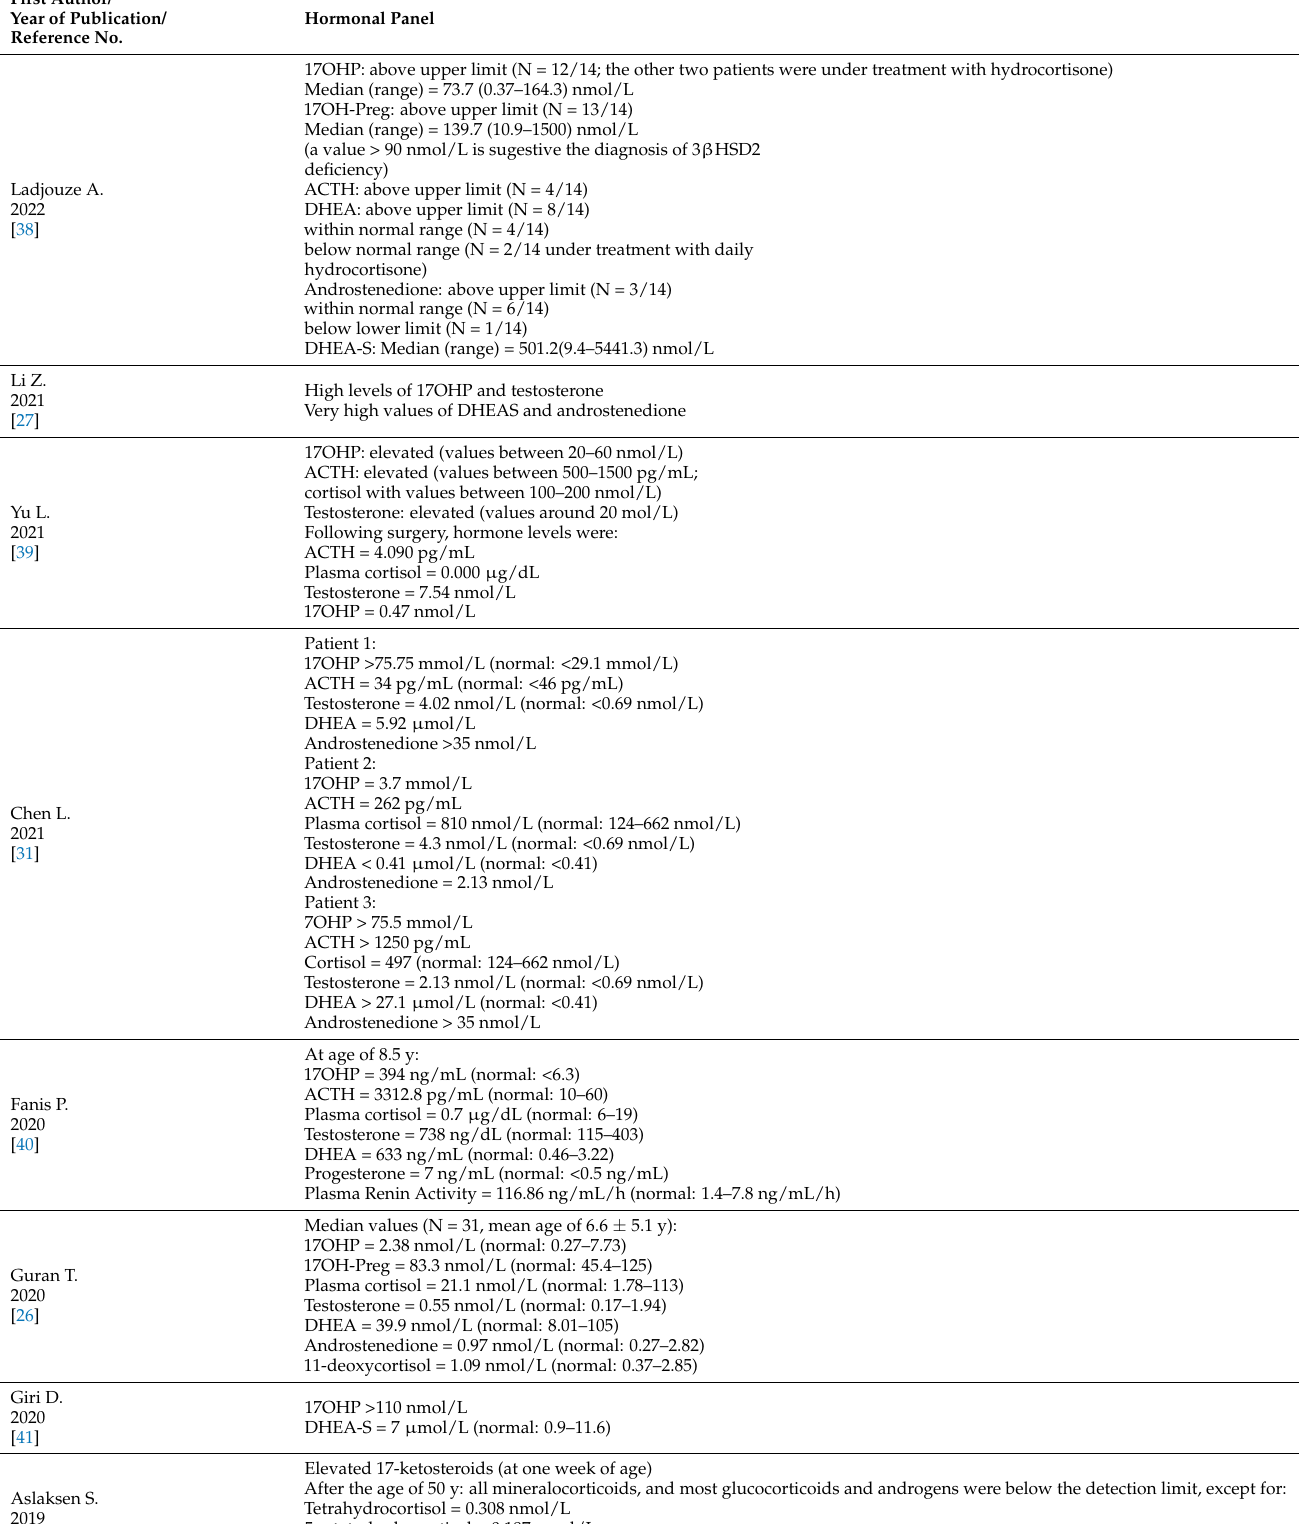
Table 2. Hormonal panel in patients diagnosed with 3 β HSD2 deficiency: studies published within between 2022 and 2012 (References: